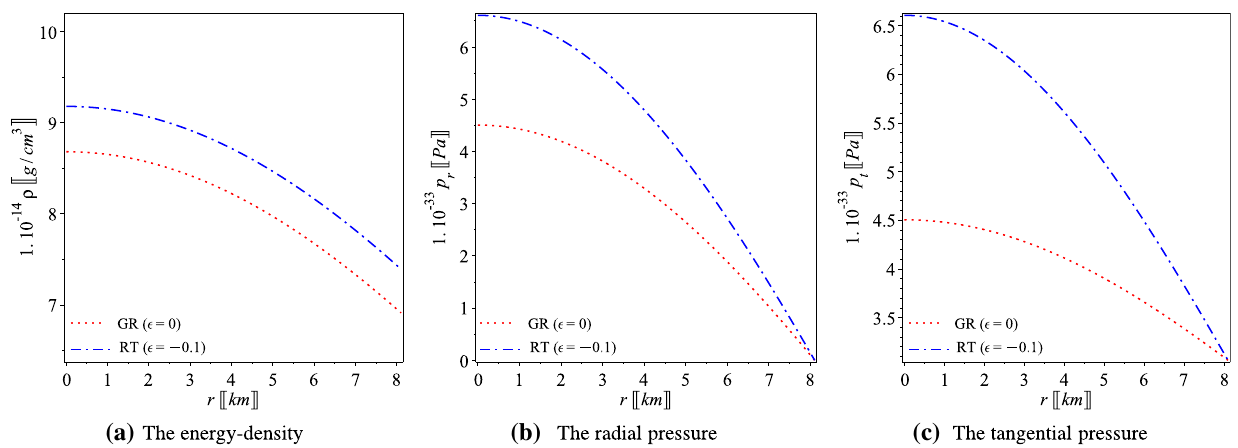
Fig. 1 Plots of the density, radial and tangential pressures given by (21) versus the radial coordinate r in km of the pulsar Her X-1 ( M =